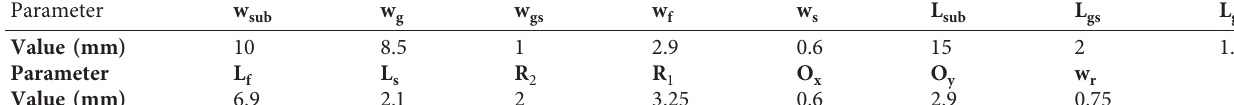
Figure 1: Configuration of the proposed ram horn-like folded antenna: (a) top view, (b) bottom-view, and (c) concatenated slit rings. Table 1: Optimized design parameter of the proposed ram horn-like folded antenna, φ